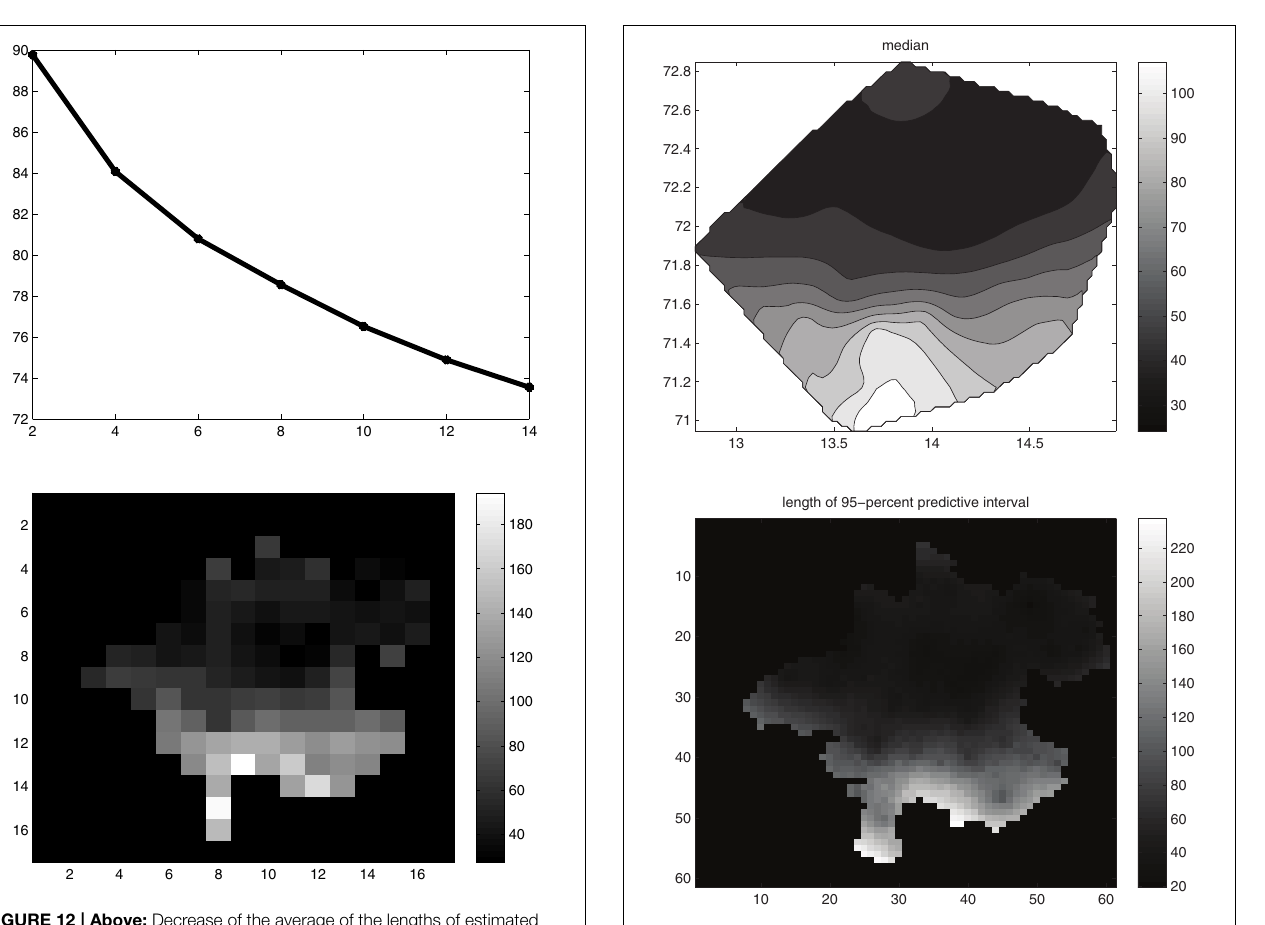
FIGURE 12 | Above: Decrease of the average of the lengths of estimated 95% predictive intervals, when adding up to 14 design locations. Below: Lengths of estimated 95% predictive intervals corresponding to the optimal 14 point design.